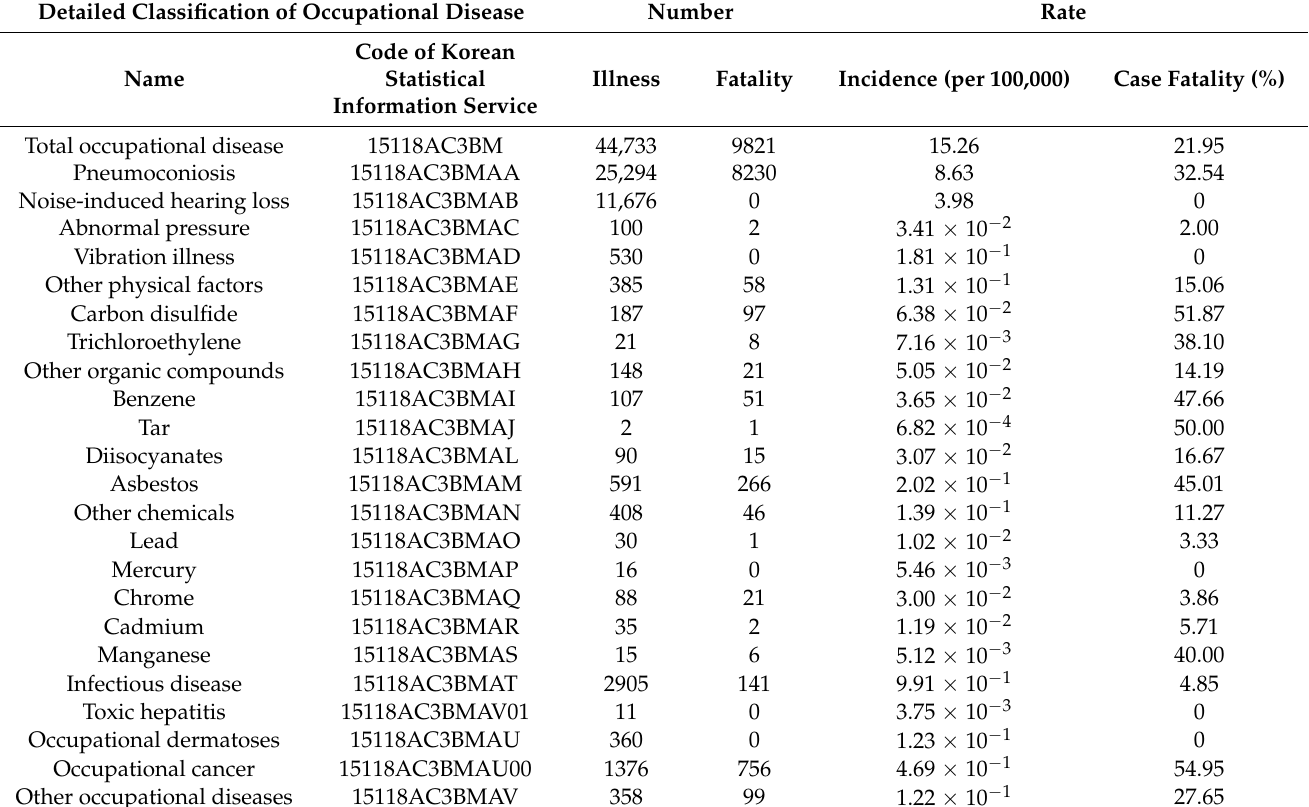
Table 2. Number and rate of illness and fatality by occupational disease type in the industrial accident statistics